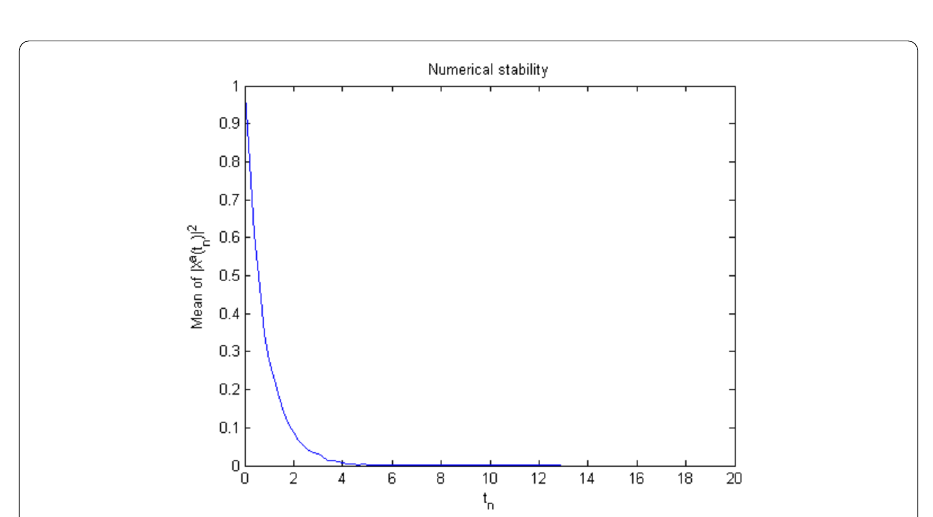
Figure 8 The average of numerical solution over 10,000 discretized Brownian paths with h = 0.2, T = 20 and c = 1 for Example